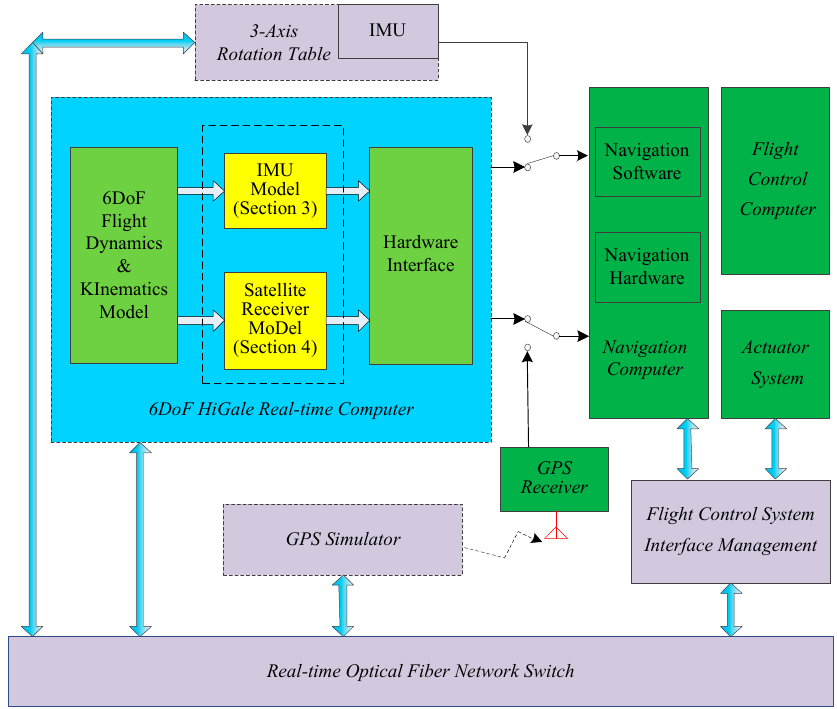
Figure 1. Illustration of the hardware-in-the-loop (HWIL) simulation system for hypersonic vehicle strapdown inertial navigation systems/global positioning system (SINS/GPS).